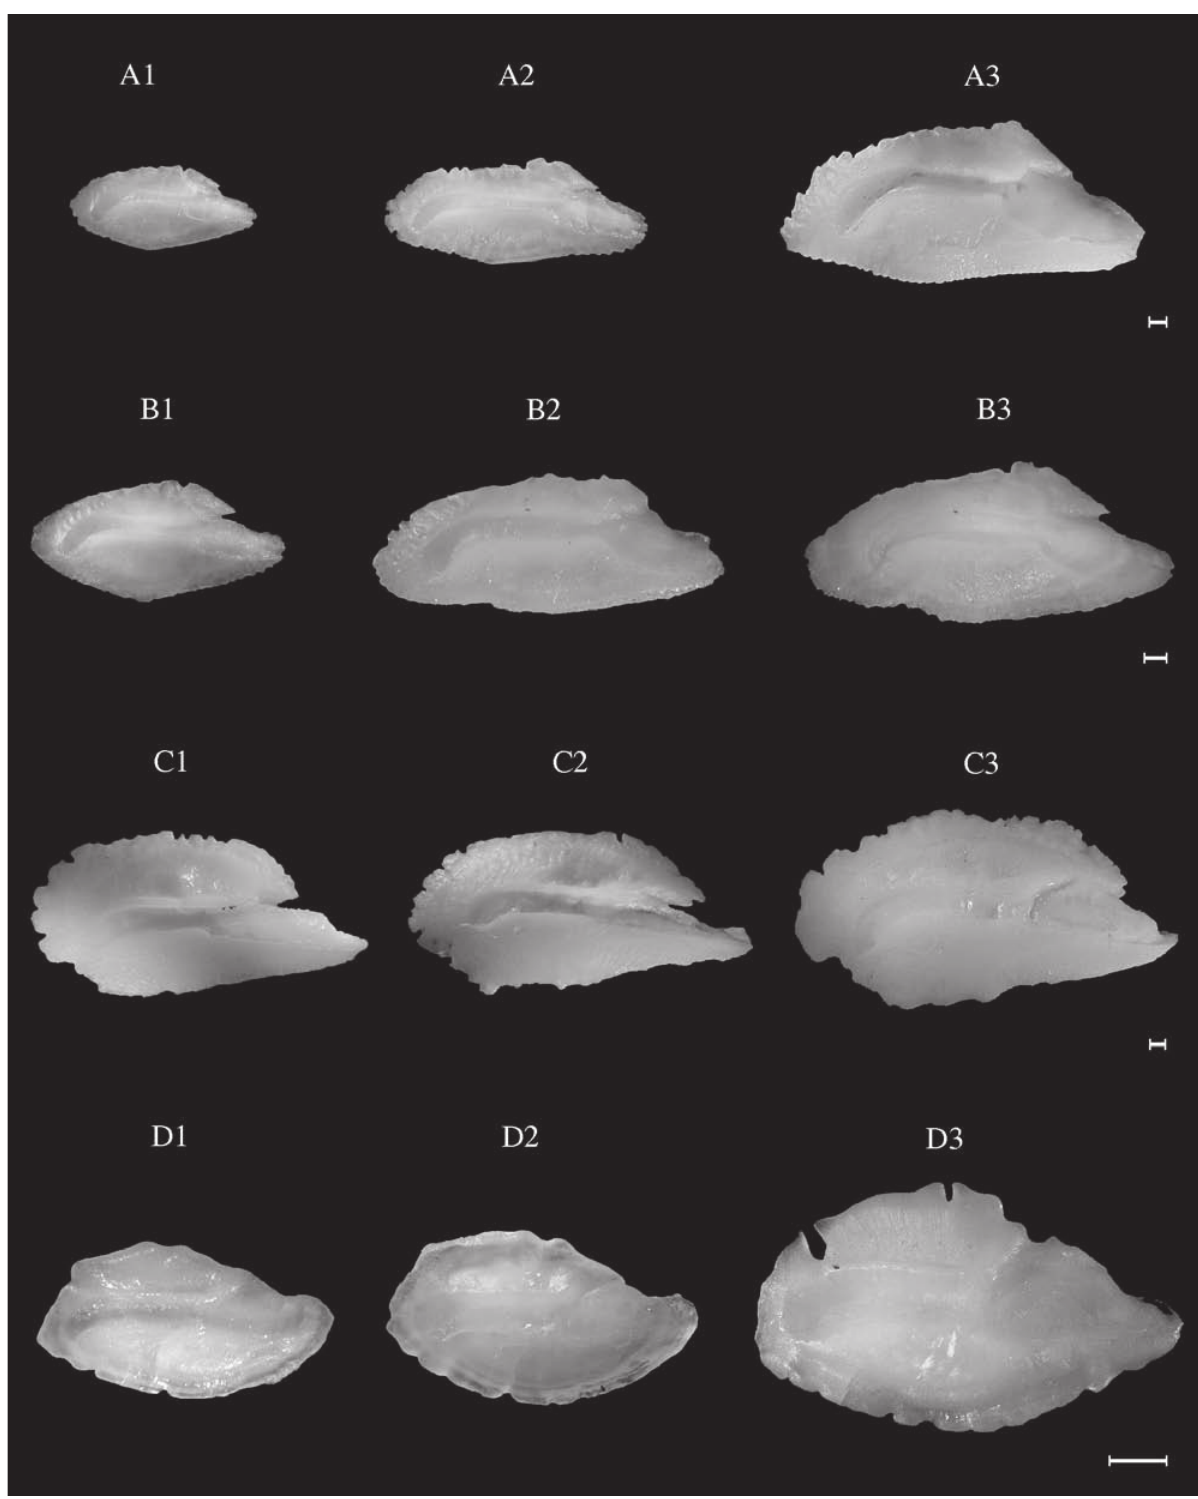
Fig. 46. – Dicentrarchus labrax . TL: A1, 24.7 cm (NEA); A2, 45.5 cm (NEA); A3, 72.0 cm (WM). Dicentrarchus punctatus TL: B1, 22.6 cm (NEA); B2, 41.0 cm (CEA); B3, 43.0 cm (WM). Polyprion americanus (CEA). TL: C1, 83.0 cm; C2, 90.6 cm; C3, 111.2 cm. Anthias anthias . TL: D1, 13.0 cm (WM); D2,13.5 cm (CEA); D3,21.2 cm (NEA). Scale bar = 1